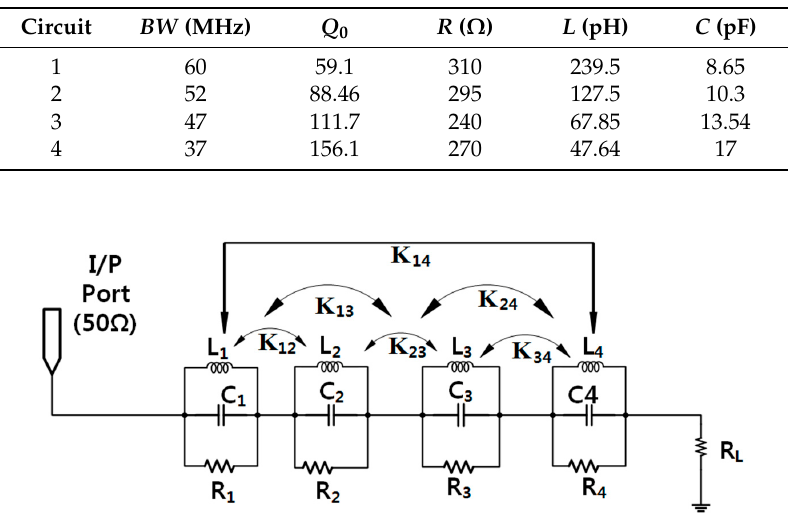
Figure 5. Equivalent lumped-element circuit model of the corresponding CSRR.